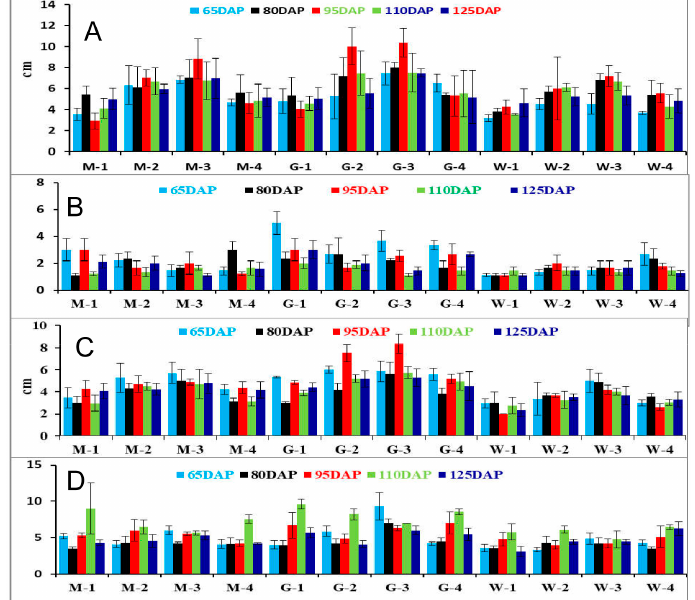
Figure 2. Root length ( A ), number of roots ( B ), shoot length ( C ) , and number of leaves ( D ) of the seedlings from immature embryos of the controlled crossing between RL and X grown in different combinations of the medium.